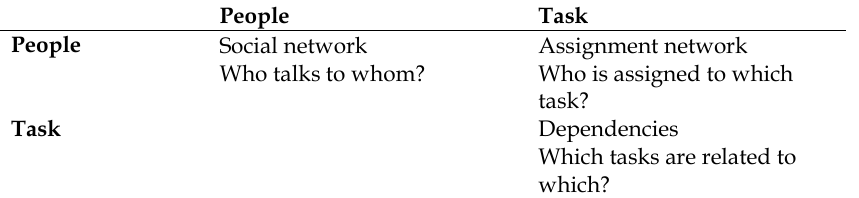
Assignment network Who is assigned to which task? Which tasks are related to which?